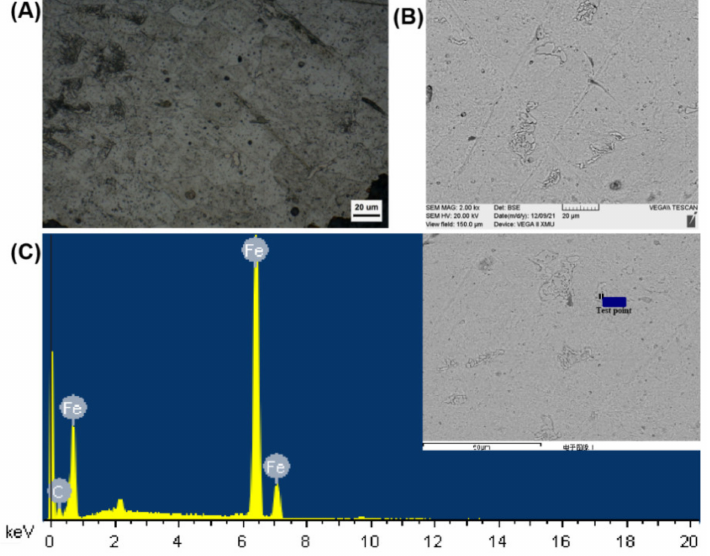
Figure 4. Metallographic analysis of iron anchor samples. ( A ) Metallographic microscopy charac- terizes the properties of metals; ( B ) scanning metallography of anchor; ( C ) EDX energy spectrum of